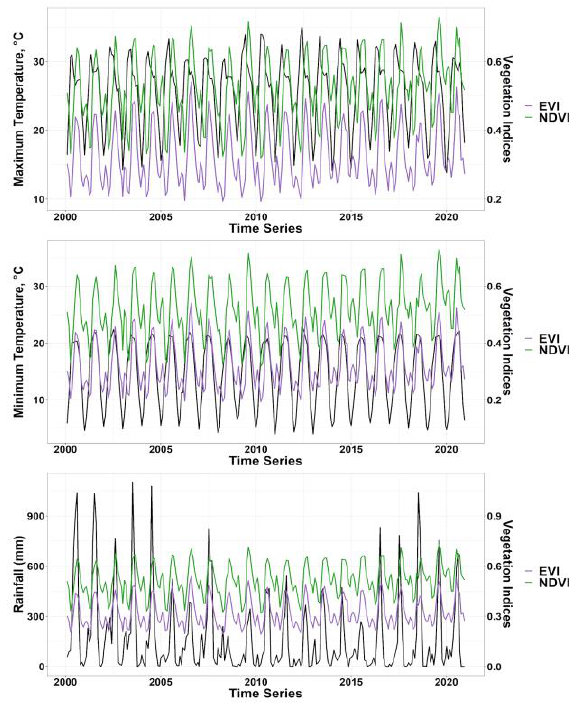
Figure 8. Temporal variation of vegetation indices and Climate Parameters in the Bageshwar District